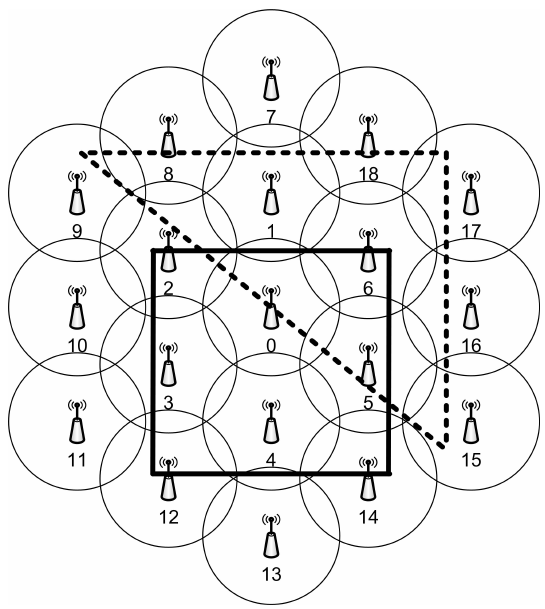
Figure 1. Simulation network model: 19 cells, two fixed mobility patterns. Table 1. Simulation parameters. DeNBs, donor Evolved Node Bs; HPI, handover (HO) performance indicator; mMRN, main mobile relay